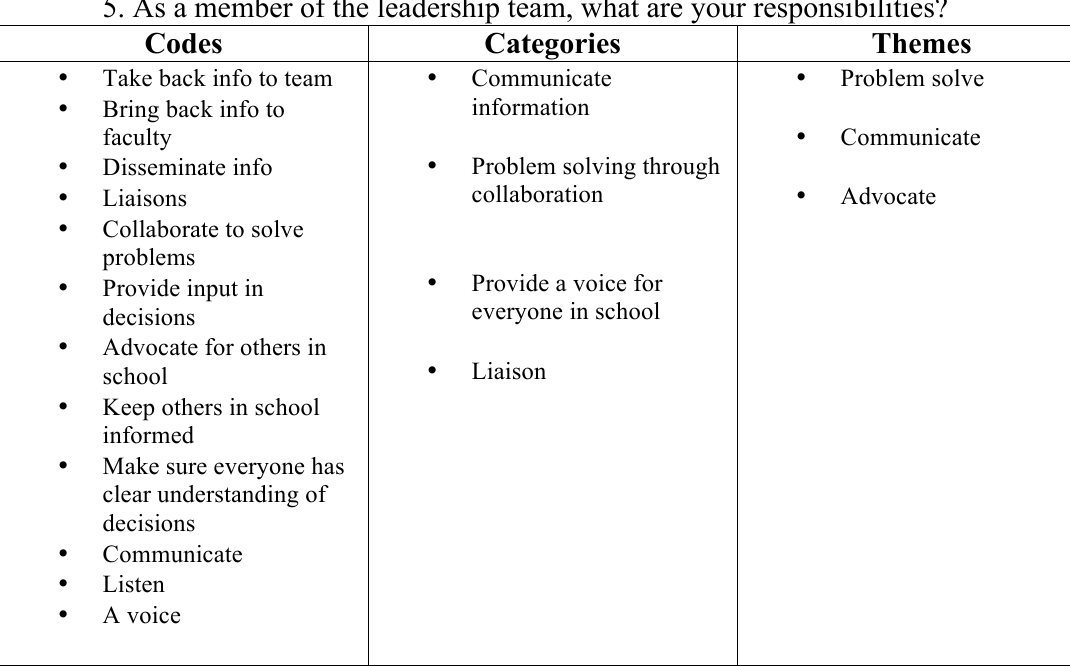
Leadership Team Members’ Question Five and Coding 5. As a member of the leadership team, what are your